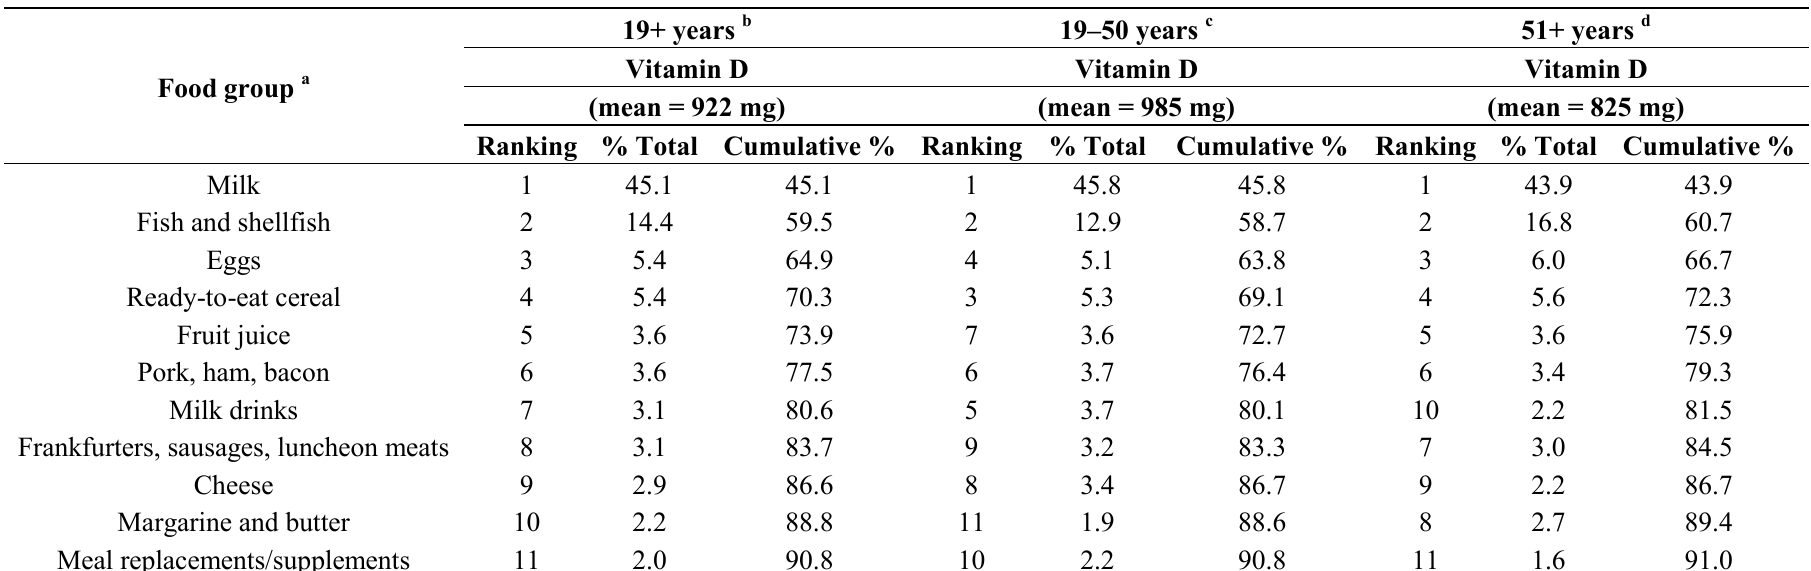
Table 9. Food sources of vitamin D among US adults (from NHANES